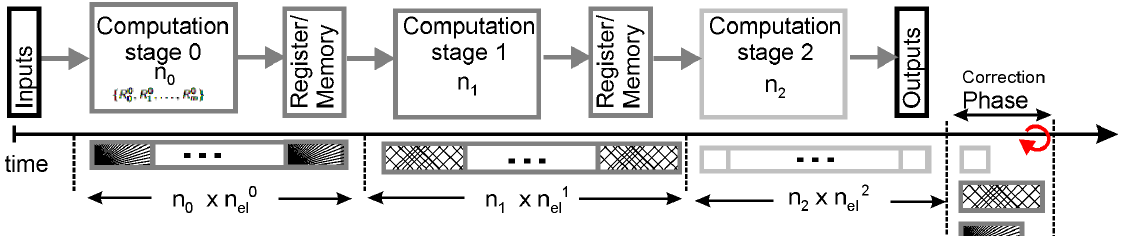
Figure 3. CFLED execution example. Three stages are considered in this example, each computing n i Each result takes n i cc for computation. First, the normal operation is performed. If, after finishing the computation, a difference is detected at the output, the correction operation is started. All three stages are executed—rewinded —in parallel with correction inputs added to designated